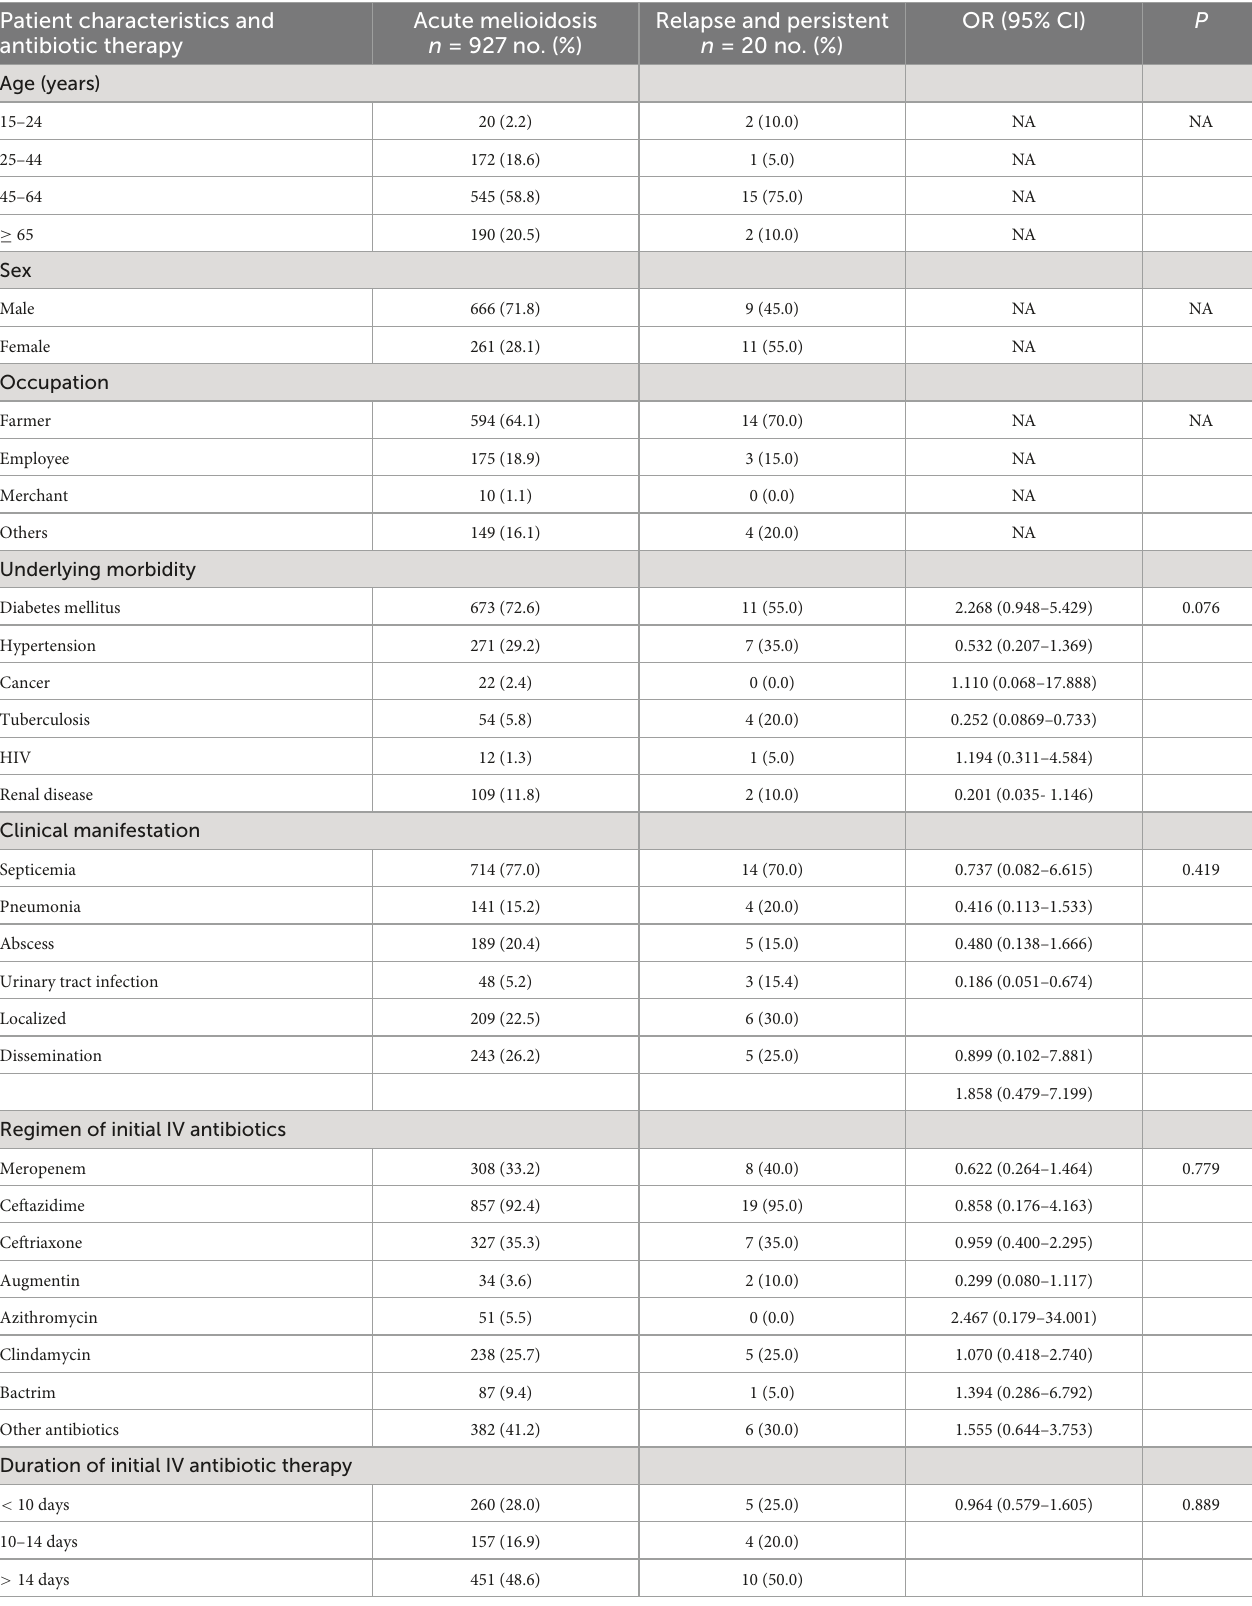
TABLE 1 Patient characteristics and risk factors for relapse and persistent infections. Patient characteristics and antibiotic therapy